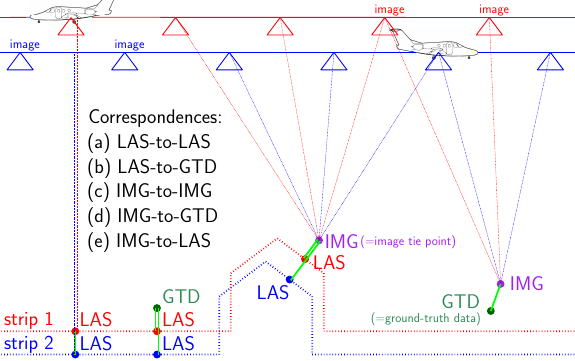
Figure 6. Schematic diagram for integrated orientation of LiDAR scans and